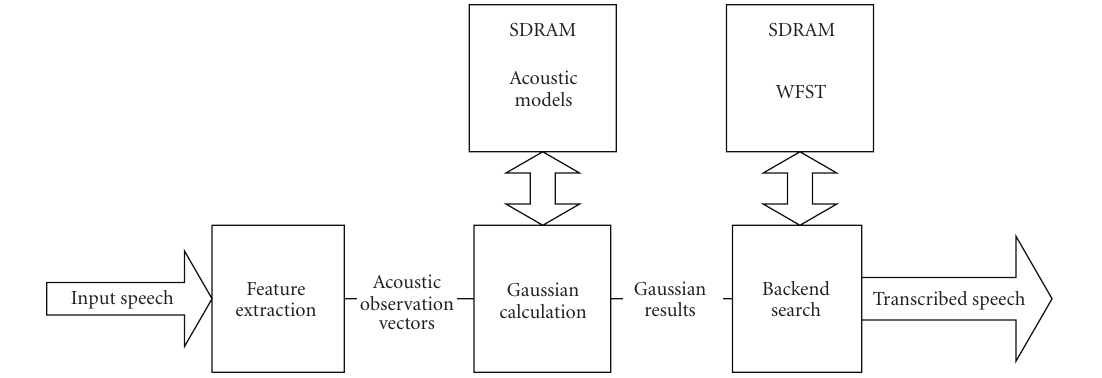
Figure 2: Overview of functional blocks.